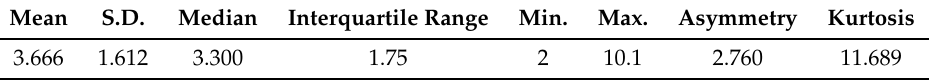
Table 8. Descriptive analysis for the copper data.